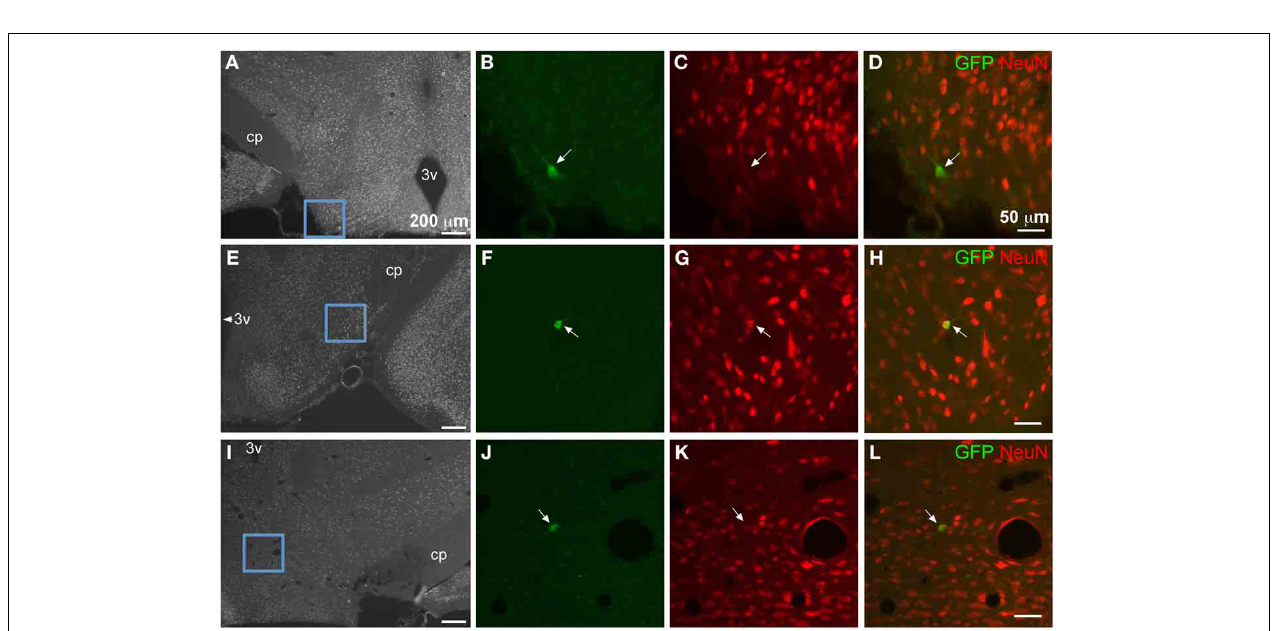
the amygdaloid nuclear complex, and superior to that, in choroid plexus of the lateral ventricle (arrow). (E) GFP-ir in the dorsal hippocampal formation, and inferior and lateral to that (arrows), in thalamus including portions of the lateral geniculate, and posterior nuclei. Note that GFP-ir in the dorsal hippocampal formation appears restricted to fibers in the molecular layer of the dentate gyrus and the stratum lacunosum-moleculare of the hippocampus.